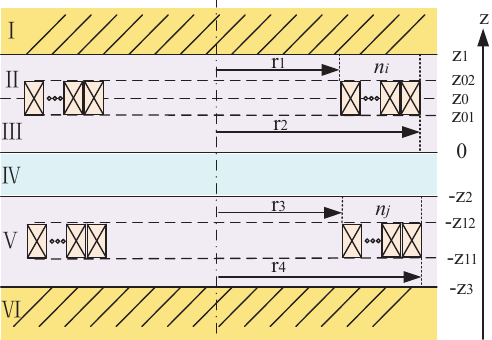
Figure 2. 2D axisymmetric view of the coils in the presence of